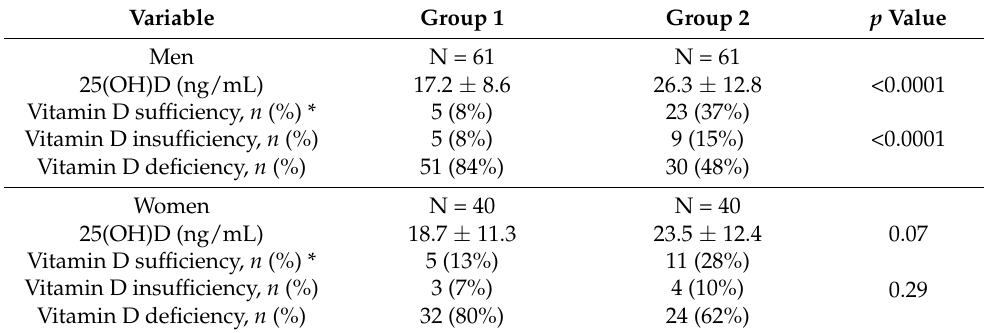
sufficient patients increased from 13% to 28% ( p = 0.29) (Figure 1B). The mean 25(OH)D concentration in females increased by 4.9 ng/mL, from 18.7 ng/mL to 23.6 ng/mL ( p = 0.07). The prevalence of vitamin D deficiency decreased in younger as well as in older patients (Table 3). In patients < 65 years old, the proportion of vitamin-D-deficient patients decreased from 81% to 44%, and the proportion of vitamin-D-sufficient patients increased from 3% to 34%. In older patients (>65 years), the prevalence of vitamin D deficiency decreased by 24%, and the prevalence of vitamin D sufficiency increased by 20% (Figure 2). In men, a statistically significant decrease of vitamin-D-deficient patients was observed in both age groups; in younger (< 65 years) males by 44%, and in older males (> 65 years) by 29% ( p < 0.001 and p < 0.002, respectively). In women, the prevalence of vitamin-D- deficient patients decreased in both age groups, although the difference was not statistically significant. In older females (> 65 years,), the prevalence of vitamin D deficiency